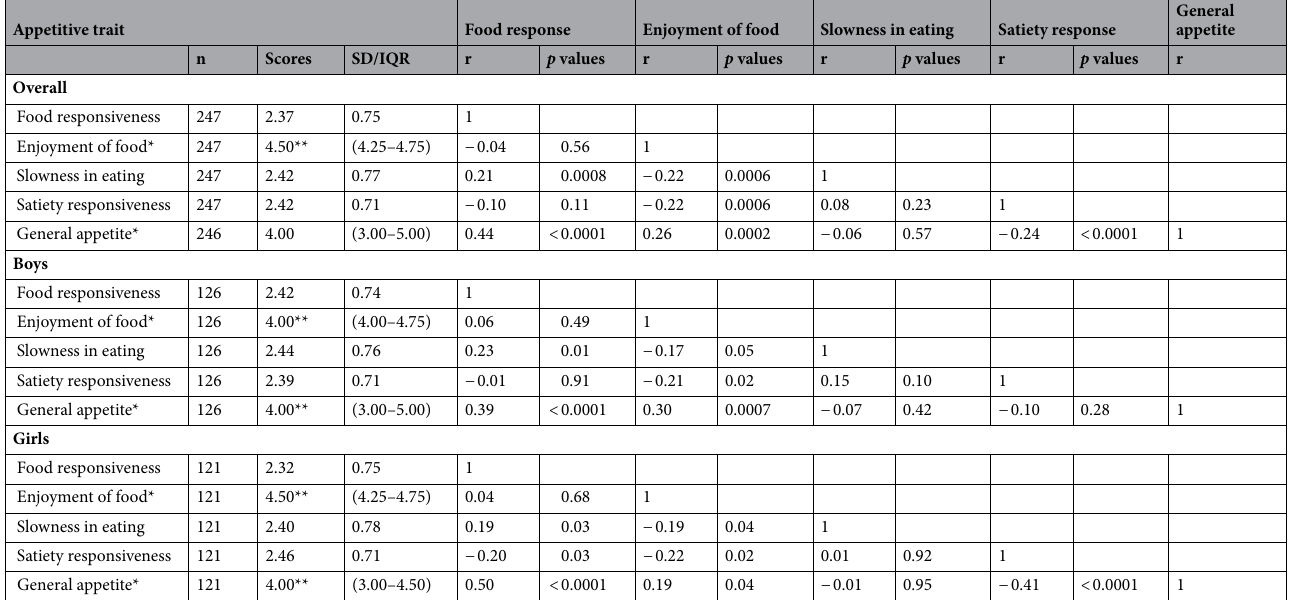
Table 2. Infant appetitive trait scores and relationships between them. n number of study participants; Scores are mean or median, SD standard deviation, IQR interquartile range, r Pearson correlation coefficients. *r